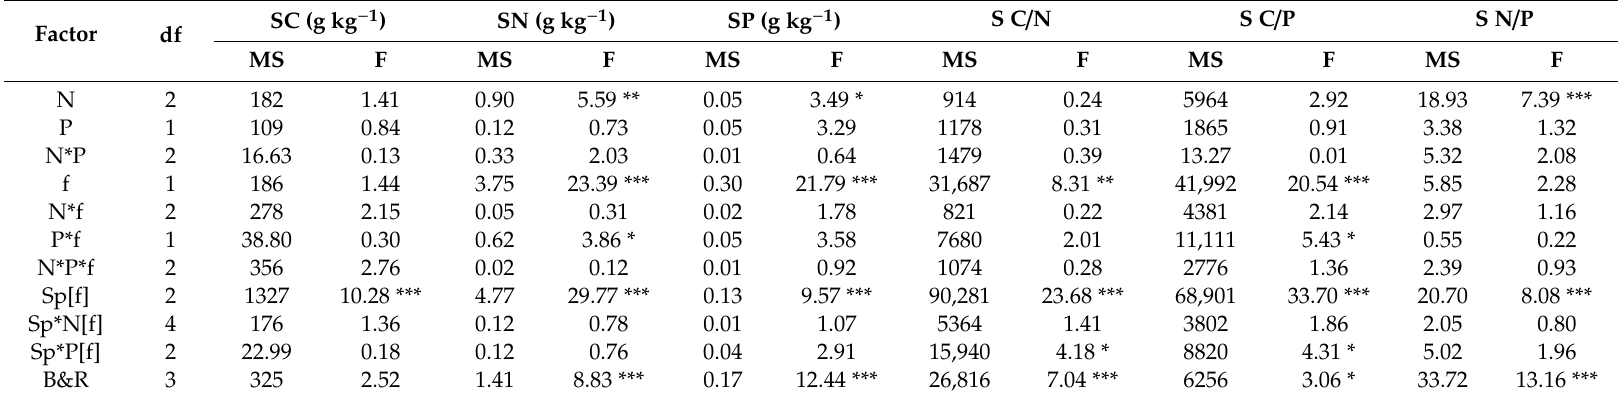
Table 3. ANOVAs on the e ff ects of N, P, and Species (Sp, nested within f) and their interactions with soil carbon, nitrogen, and phosphorus (C, N, P), soil C / N, soil C / P, and soil N / P. Terms are the same as in Table 2. B&R is randomized complete block design. df is the degrees of freedom. *: p < 0.05; **: p < 0.01; ***: p <